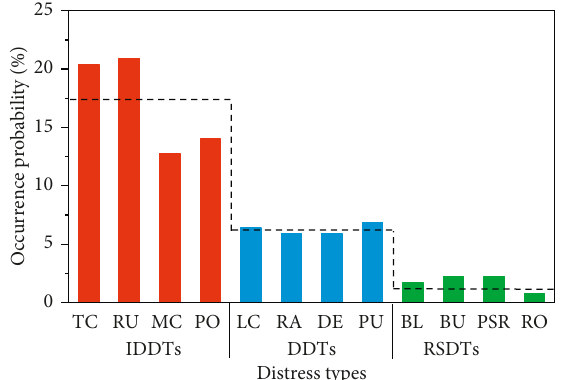
Figure 10: Distribution of occurrence probabilities of different distress